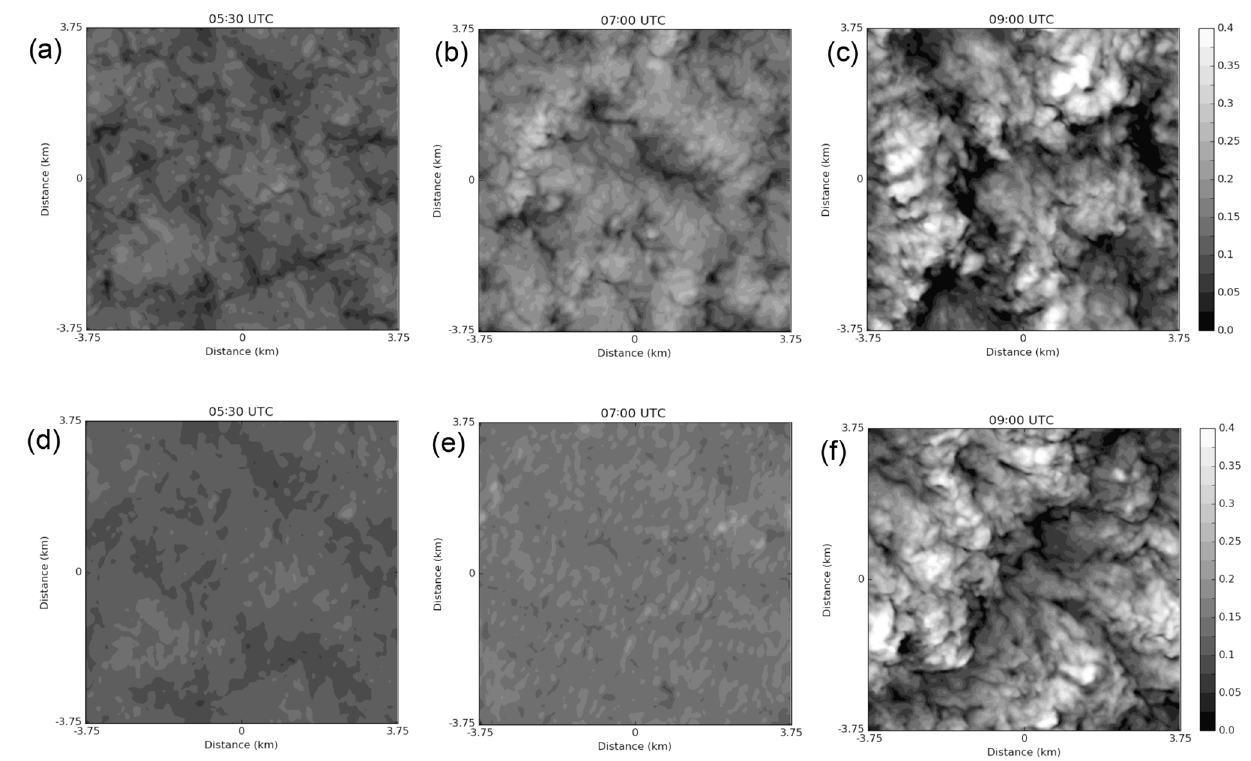
Figure 9. Maps showing the spatial distribution of LWP (kgm − 2 ) within the model domain at 05:30, 07:00, and 09:00UTC for CASIM_NO_PROC ( a–c ) and CASIM_NO_SED ( d–f ).